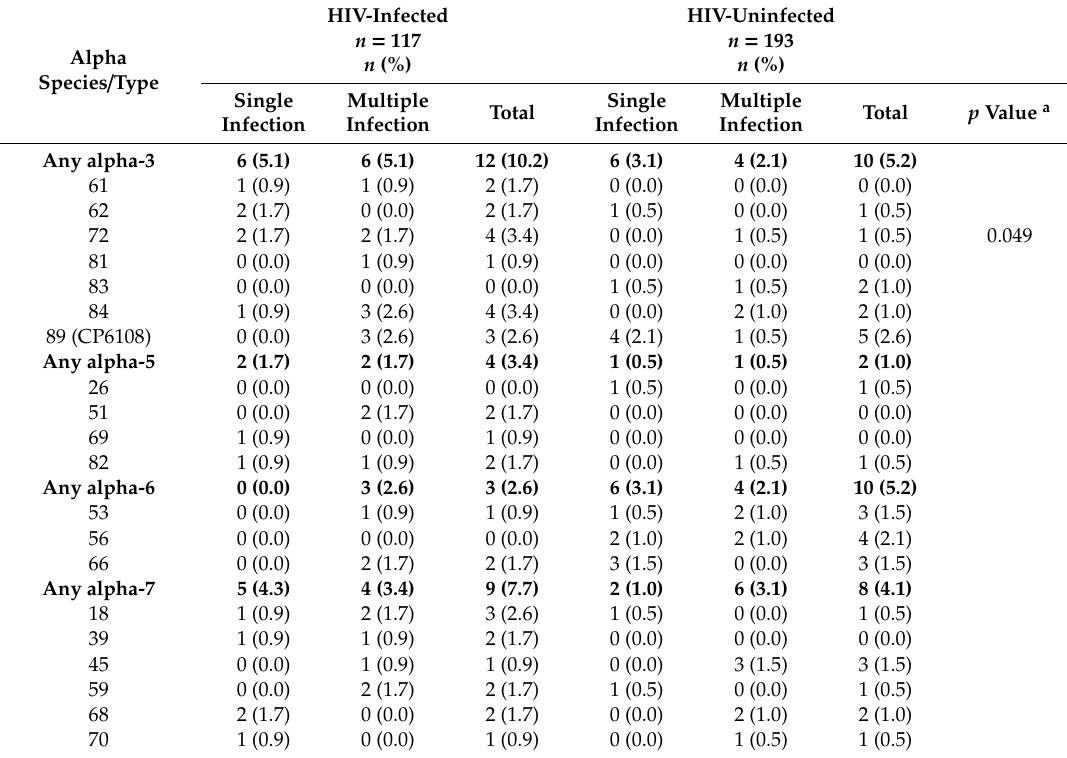
Table 2. Species-specific and type-specific prevalence of alpha HPVs in single and multiple oral infections among the 310 MSM of the Oral/Oropharyngeal HPV in Men At Risk (OHMAR) study according to HIV status .